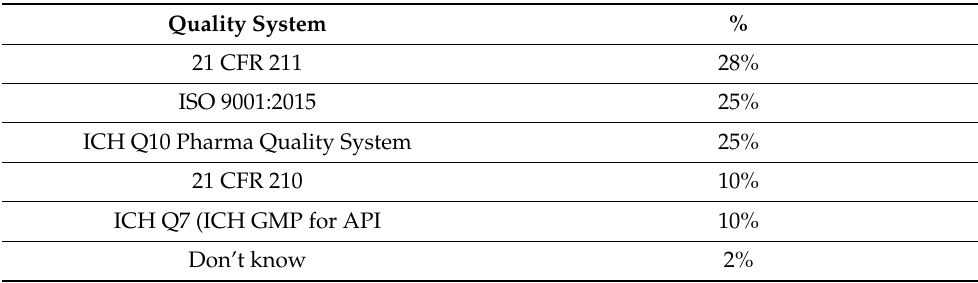
Table 2. Quality System and/or Good Manufacturing practise regulations/guidelines adhered to by Irish pharma